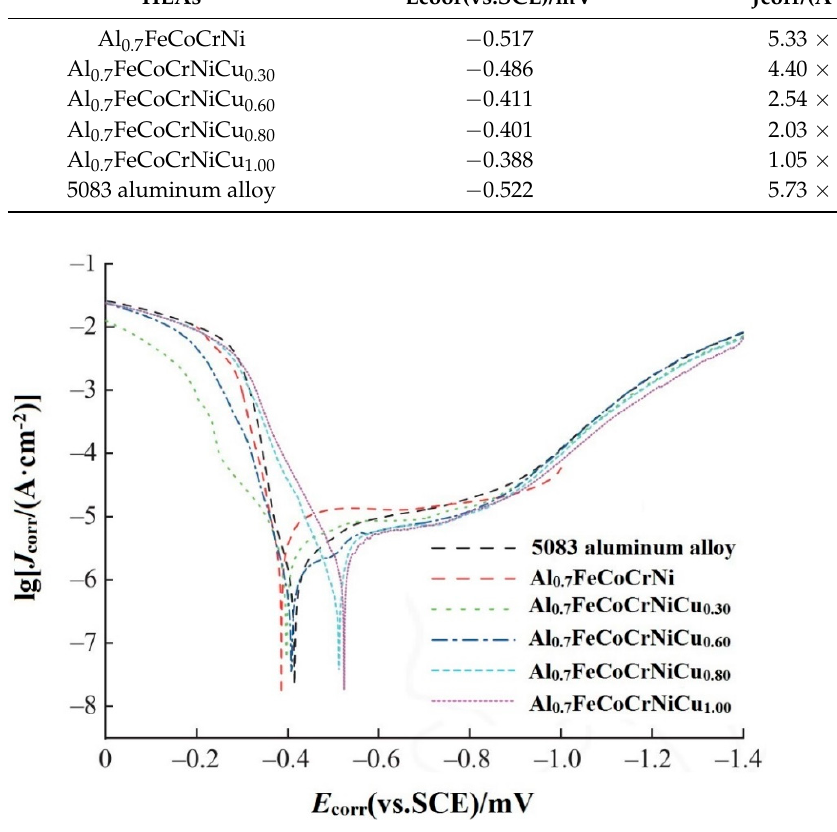
Figure 6. Potentiodynamic polarization curves of the Al 0.7 FeCoCrNiCu x high-entropy alloys in 3.5%NaCl solution.